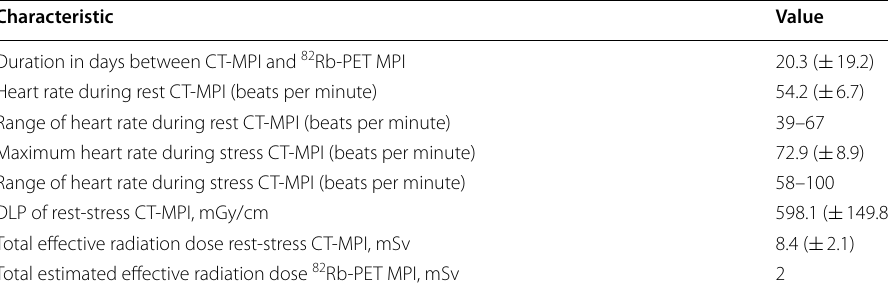
Average standard deviation; Effective dose ± CT-MPI computed tomography myocardial perfusion imaging; 82 Rb PET MPI Rubidium-positron emission tomography myocardial perfusion imaging